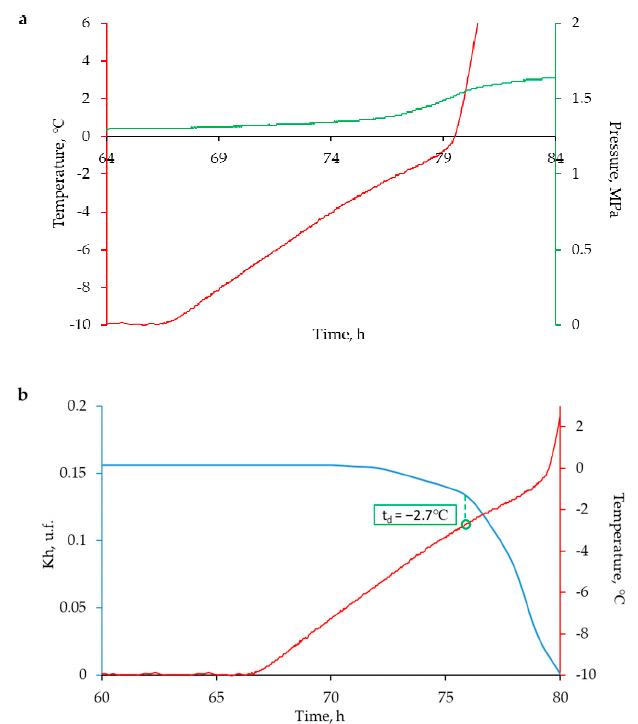
Figure 4. Time-dependent change of temperature and pressure ( a ), and hydrate coefficient ( Kh ) ( b ) in frozen hydrate-bearing clay silt exposed to warming. t d is the temperature corresponding to the onset of rapid pore hydrate dissociation.